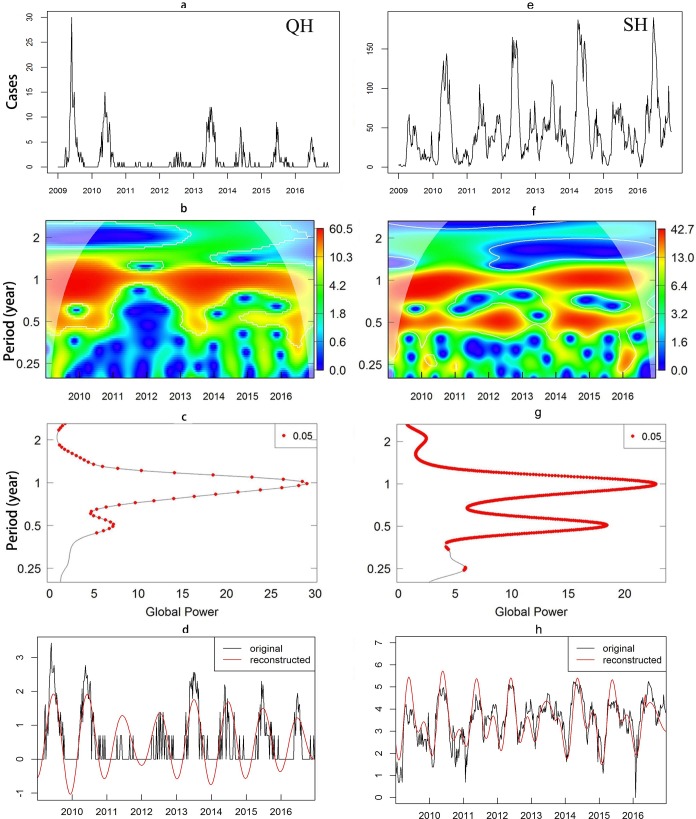
Temporal pattern and periodicity of HFMD.a/e. Weekly pattern of HFMD in Huangzhong (Qinghai) and Fengxian (Shanghai). b/f, Local wavelet power spectrum in Huangzhong and Fengxian. c/g, Global wavelet spectrum (red points represent periods with 95% statistical significance) in Huangzhong and Fengxian. d/h, Major epidemic component of the incidence series in Huangzhong (mainly annual) and Fengxian (mainly annual and semi-annual), reconstructed with wavelet spectral analysis from the components in their respective period. All the plots were created using R software (R Development Core Team 2013).